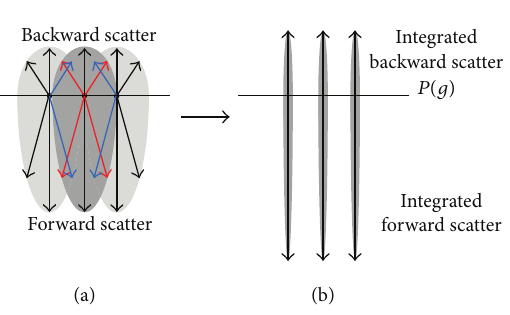
Figure 2: Integration of the phase